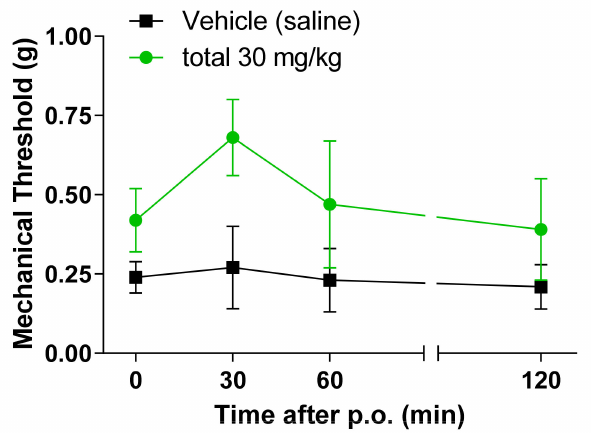
Figure 5. Effect of Symplocos chinensis f. pilosa Ohwi water extract in the Spared Nerve Injury (SNI) von Frey test in mice. Data are expressed as mean ± SD; n = 4 mice per